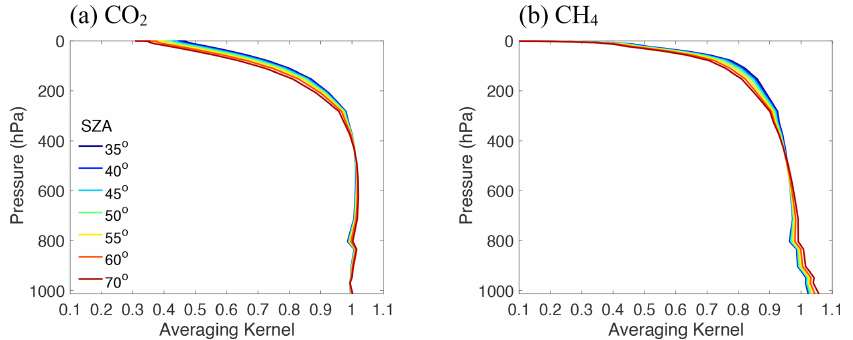
Figure 9. Examples of column averaging kernels for (a) CO 2 and (b) CH 4 with different SZAs. These are from observations of the Santa Anita surface target on 28 September